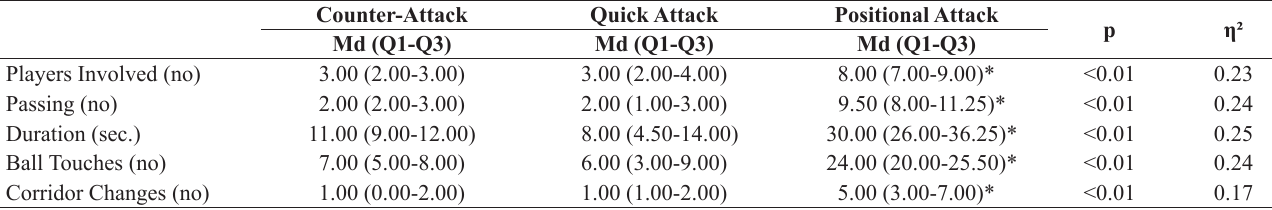
Table 3. Comparison of tactical-technical indicators between different offensive methods.